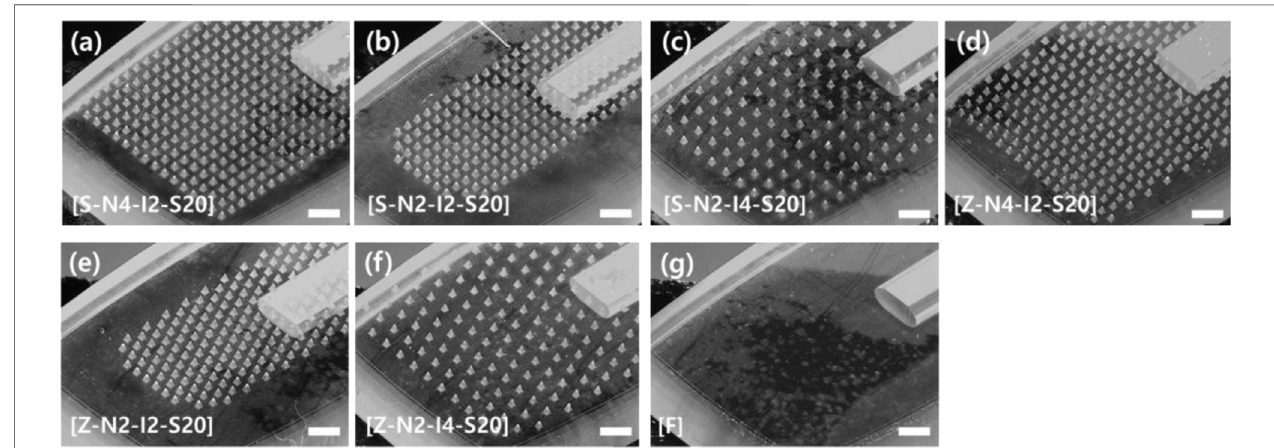
FIGURE 5 | Optical microscope image of seven types of microneedle swab heads according to the number, spacing, and pattern of microneedles (scale bars, 1 mm). (A) S-N4-I2-S20:Straight-No.496ea-Intervalof200 μ m-sharpnessof20 μ m. (B) S-N2-I2-S20:Straight-No.248ea-Intervalof200 μ m-sharpnessof20 μ m. (C) S-N2-I4-S20: Straight-No. 248 ea-Interval of 400 μ m-sharpness of 20 μ m. (D) Z-N4-I2-S20: Zigzag-No. 496 ea-Interval of 200 μ m-sharpness of 20 μ m. (E) Z-N2-I2- S20: Zigzag-No. 248 ea-Interval of 200 μ m-sharpness of 20 μ m. (F) Z-N2-I4-S20: Zigzag-No. 248 ea-Interval of 400 μ m-sharpness of 20 μ m. (G) Flat head without